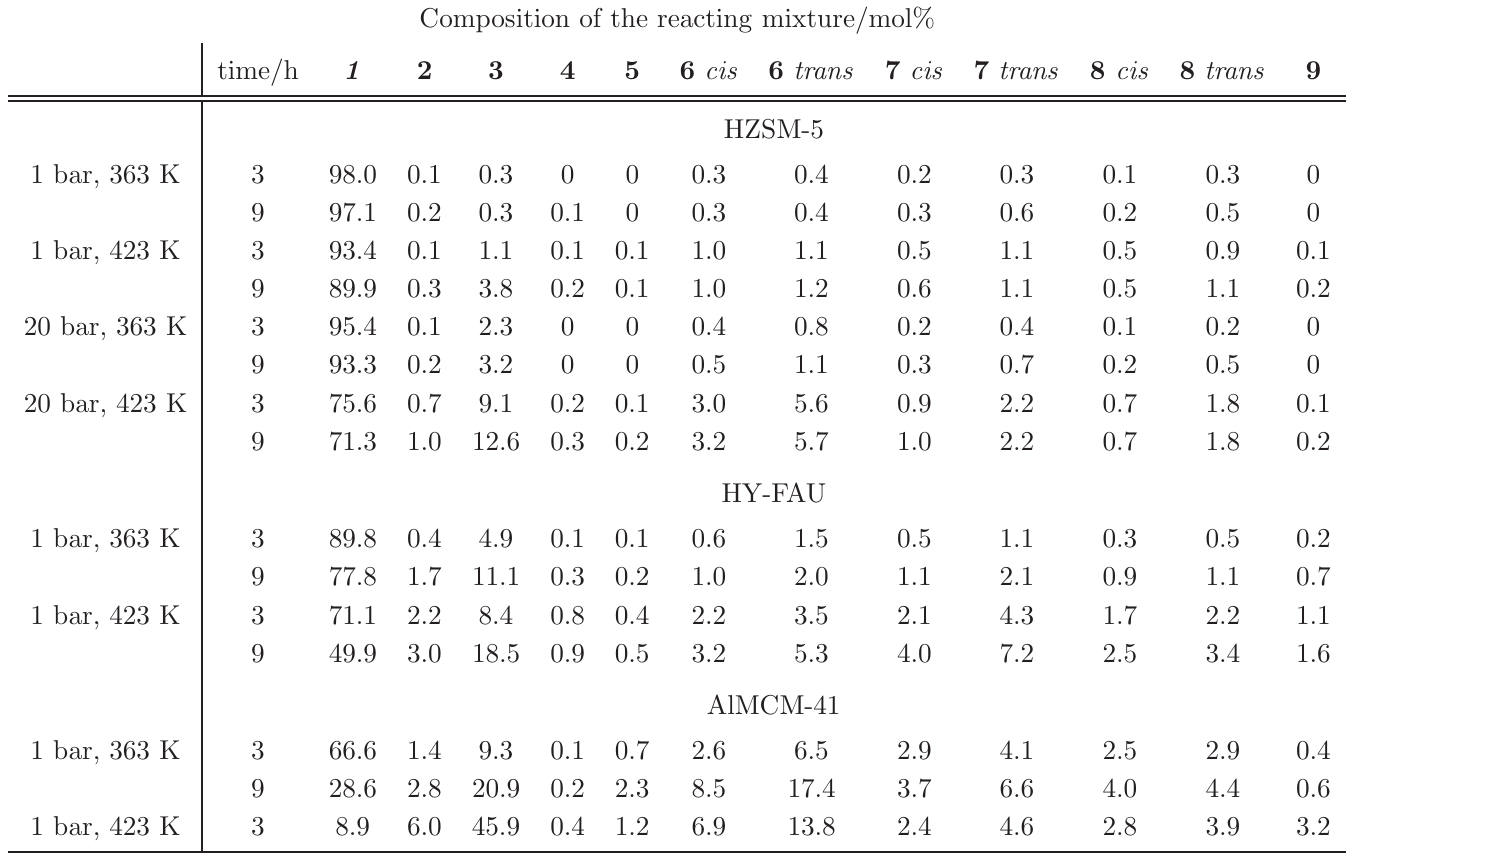
Table 2 Composition of the reacting mixture in an autoclave (30 cm 3 ) in the transformations of methyloxirane ( 1 ) at 363 K (first entry at each pressure) or 423 K (second entry at each pressure) over various molecular sieves (catalyst 100 mg, starting mixture: 2 cm 3 of 1 and 2 cm 3 of CH 2 Cl 2